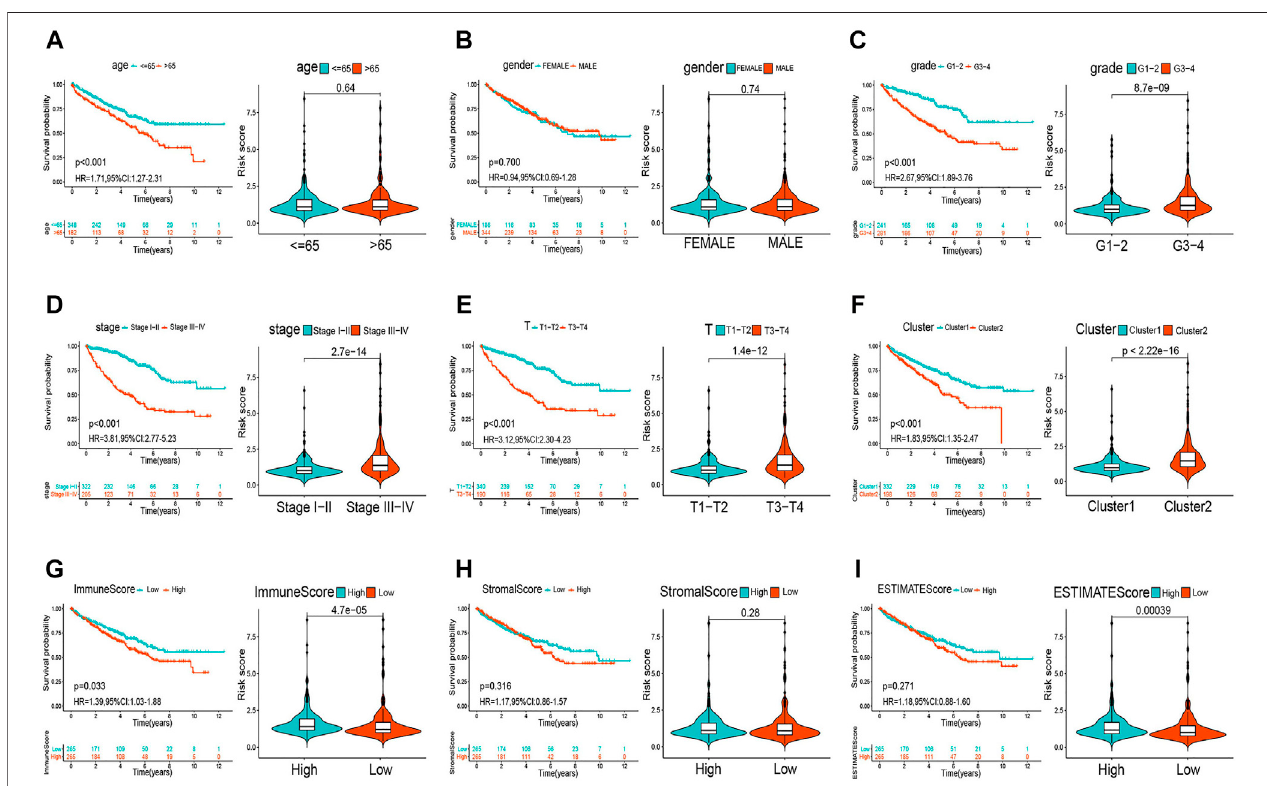
FIGURE 9 | Relationships between the risk score and clinicopathological parameters. Distribution of risk scores according to age (A) , sex (B) , tumor grade (C) , clinical stage (D) , T stage (E) , cluster (F) , immune score (G) , stromal score (H) , and ESTIMATE score (I) .